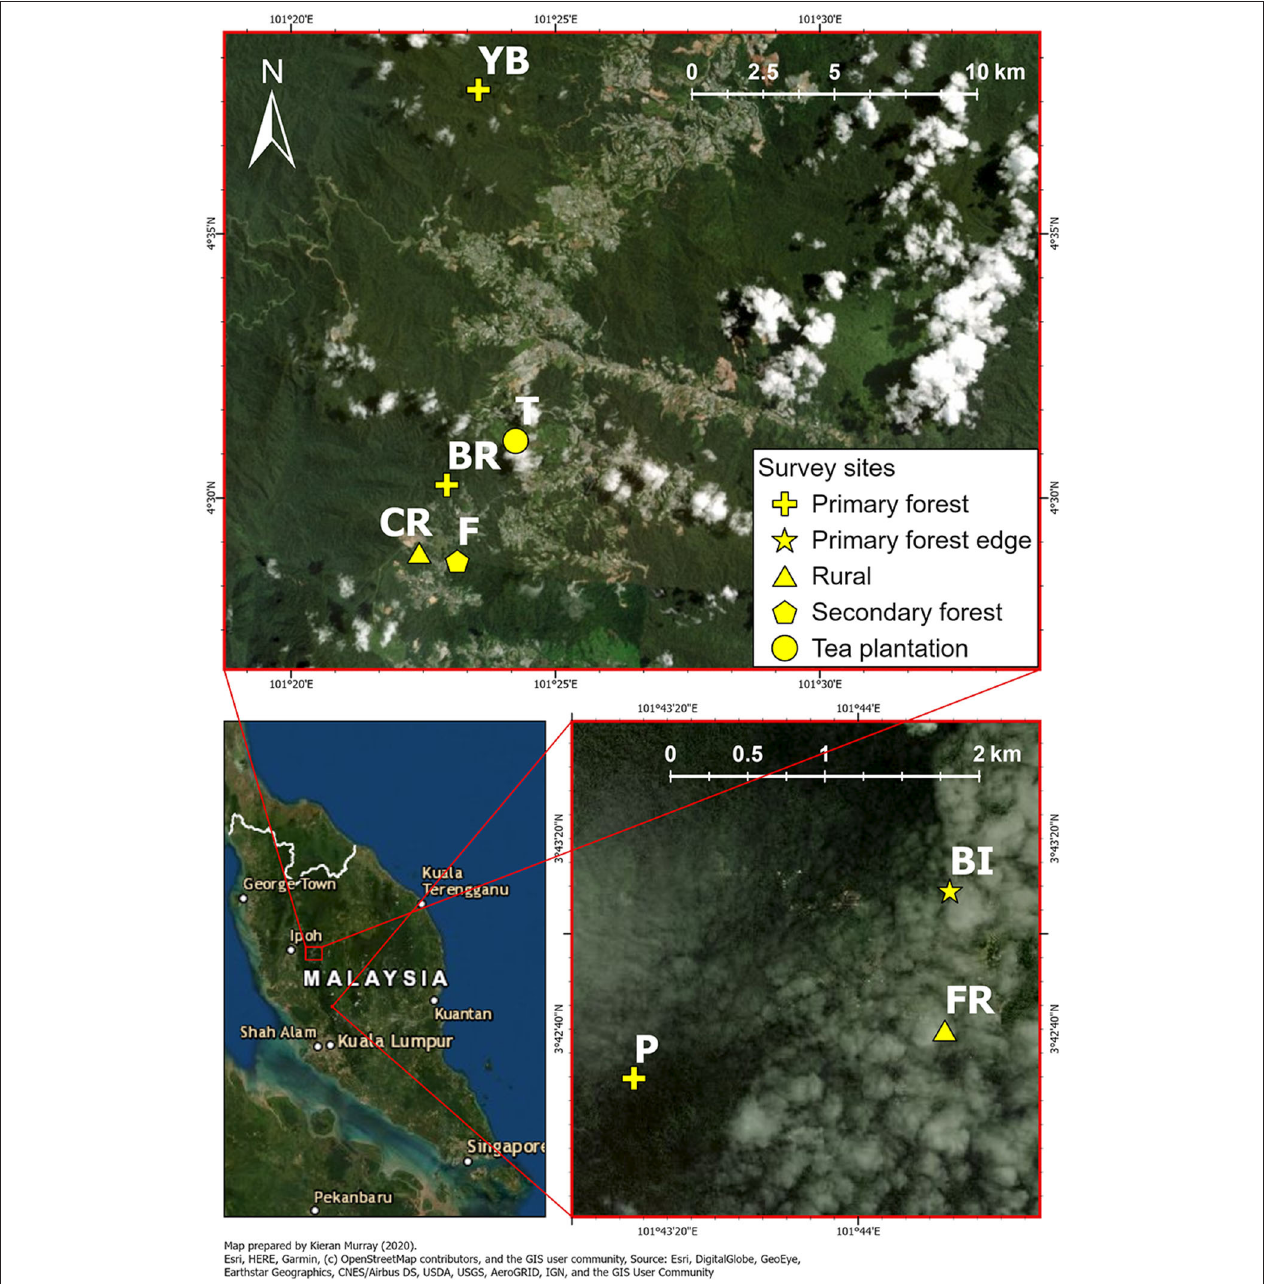
FIGURE 1 | Satellite map of study sites of varying habitat disturbance levels within Cameron and Lojing Highlands (top panel) and Fraser’s Hill (bottom right panel), Peninsular Malaysia. For site abbreviations and detailed descriptions, refer to Table 1